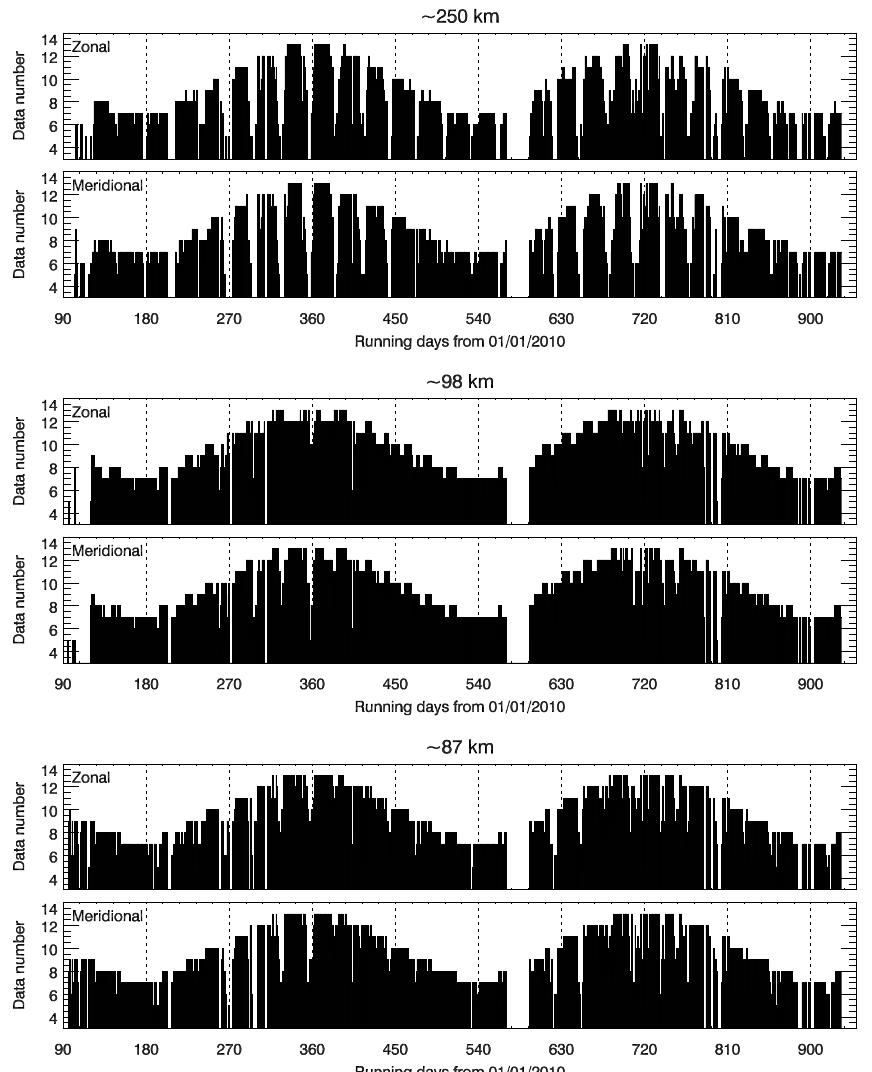
Fig. 1. Distributions of the valid data numbers in zonal and meridional winds in each night at the three airglow layers during April 2010– July